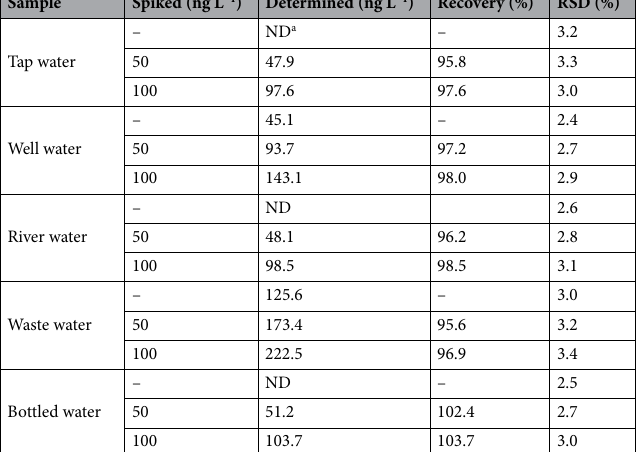
Table 8 . Results of HGAAS analysis of water samples spiked with known amounts of As(III). a not